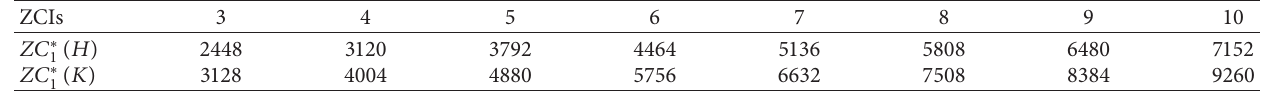
for H and K networks on dimensions 3 ≤ n ≤ 10. 1